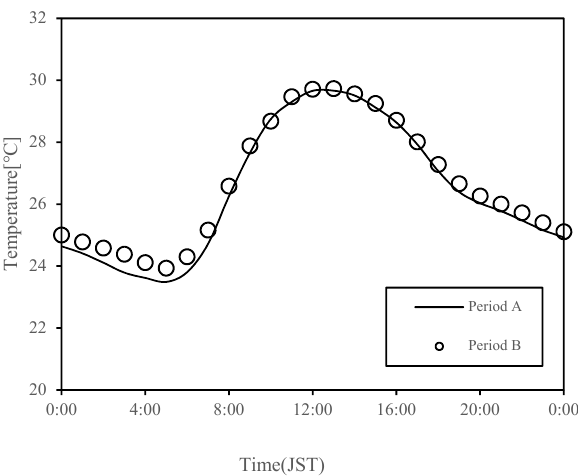
Figure 4. Average diurnal temperature fluctuations at Sendai Local Meteorological Observatory during period A (August 2010 to 2021) and period B (August 2018 to 2020) on sea breeze days.